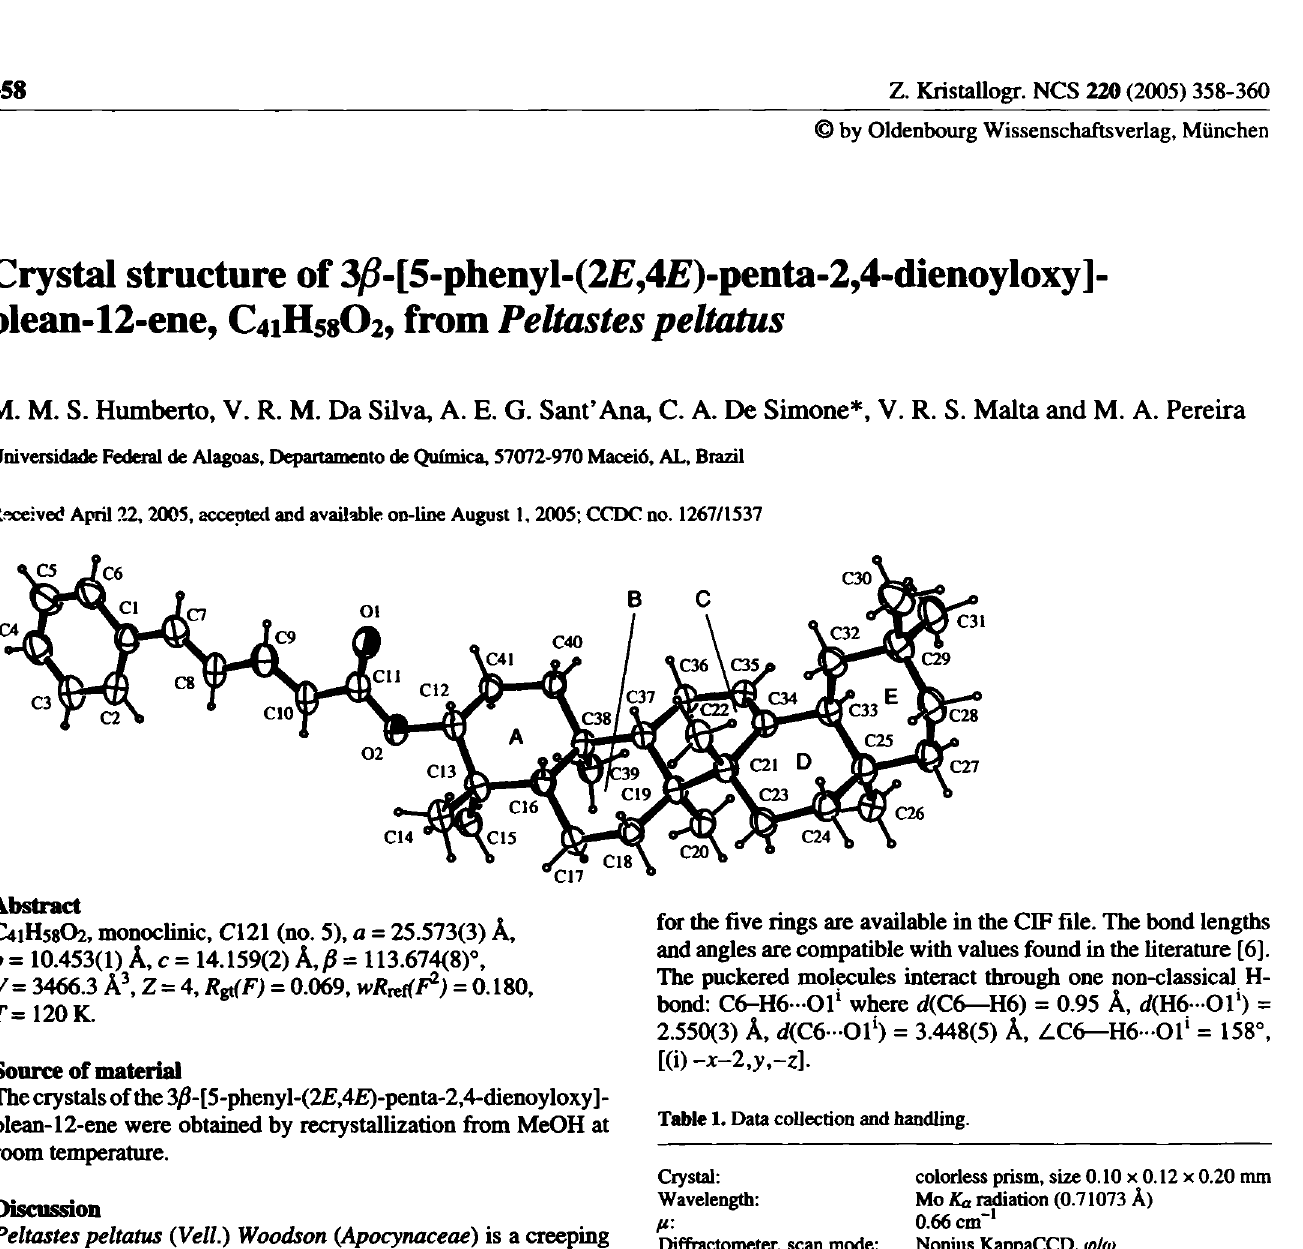
Table 1. Data collection and handling.